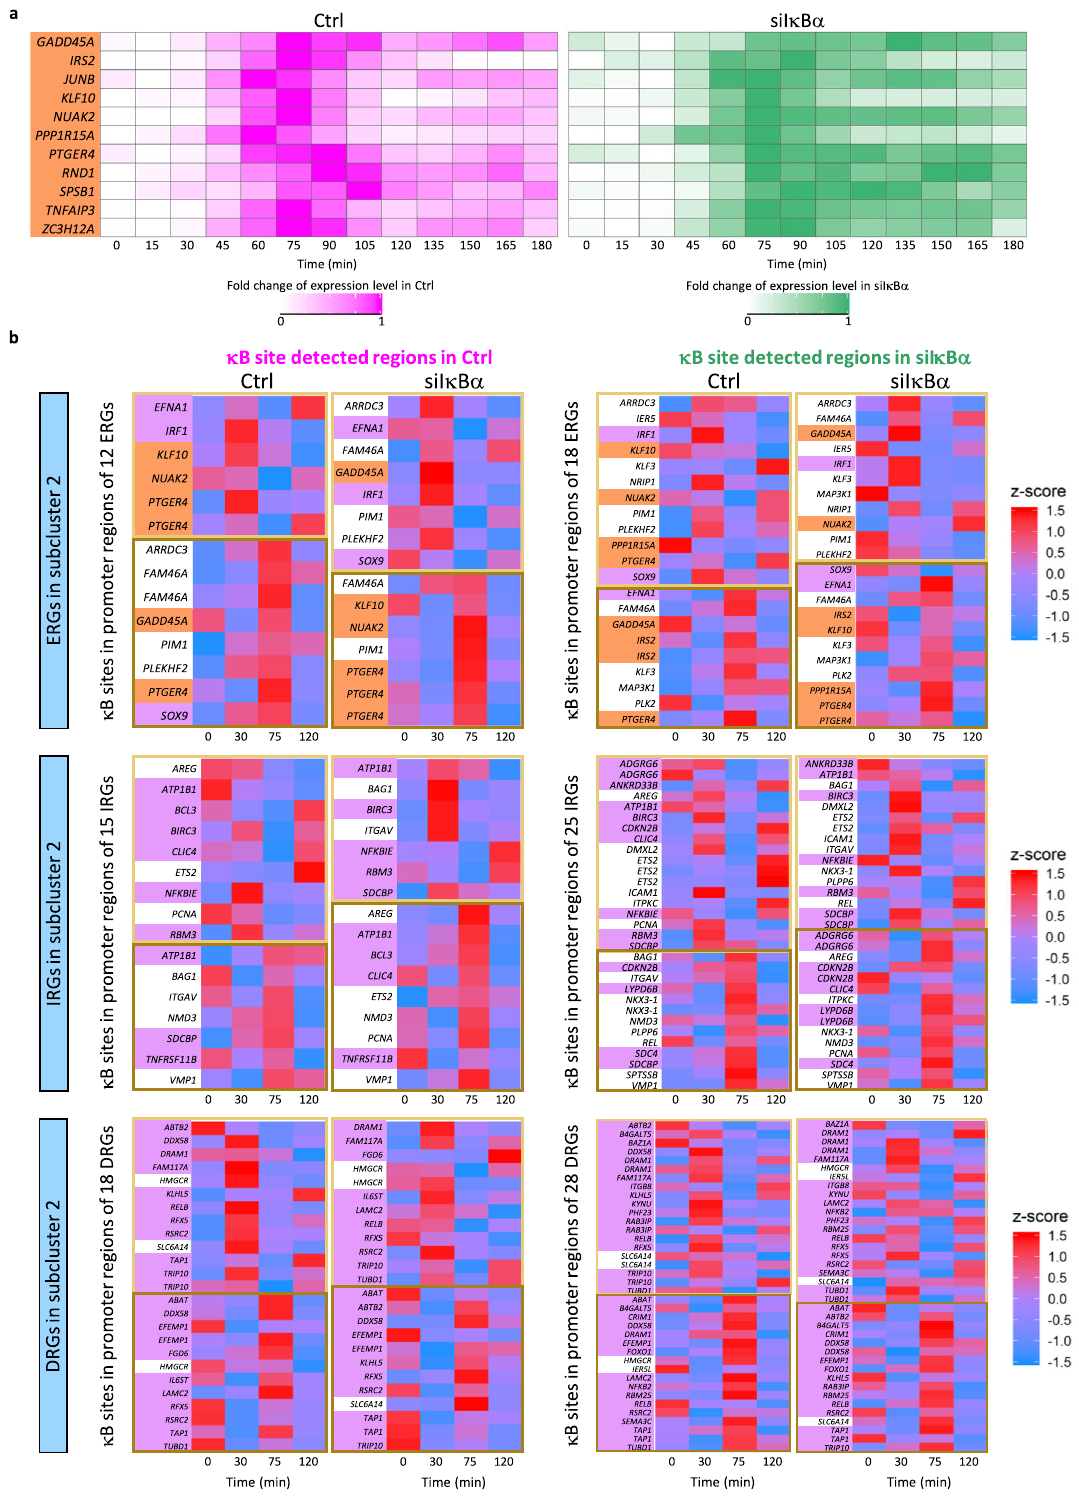
Fig. 4 Chromatin remodeling observed for many post-induction repressed ERGs in subcluster 2. a Heatmaps of time-course fold change in expression from data of all post-induction repressed genes that were demonstrated by the 3-state cycle model or model v4 (highlighted in orange). Genes shown in the heatmaps all belong to the ERGs in subcluster 2. b Heatmaps of time-course chromatin accessibility at κ B sites in promoter regions of ERGs, IRGs, and DRGs in subcluster 2, which showed the start of decrease in chromatin accessibility at least at 30 (light brown box) or 75 (brown box) min in both Ctrl and siI κ B α . Genes highlighted with orange are post-induction repressed ERGs in subcluster 2 that were best demonstrated by 3-state cycle model or model v4. Genes highlighted with purple are genes that were demonstrated by any of the 4 models but did not show post-induction repression in